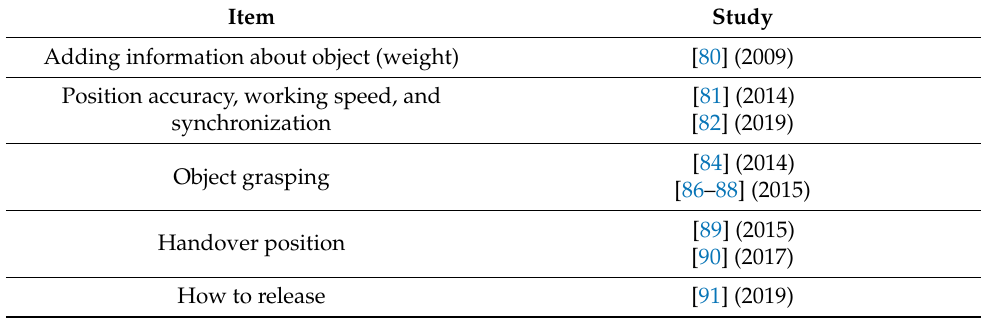
Table 5. Design studies on the handover motion of robots.